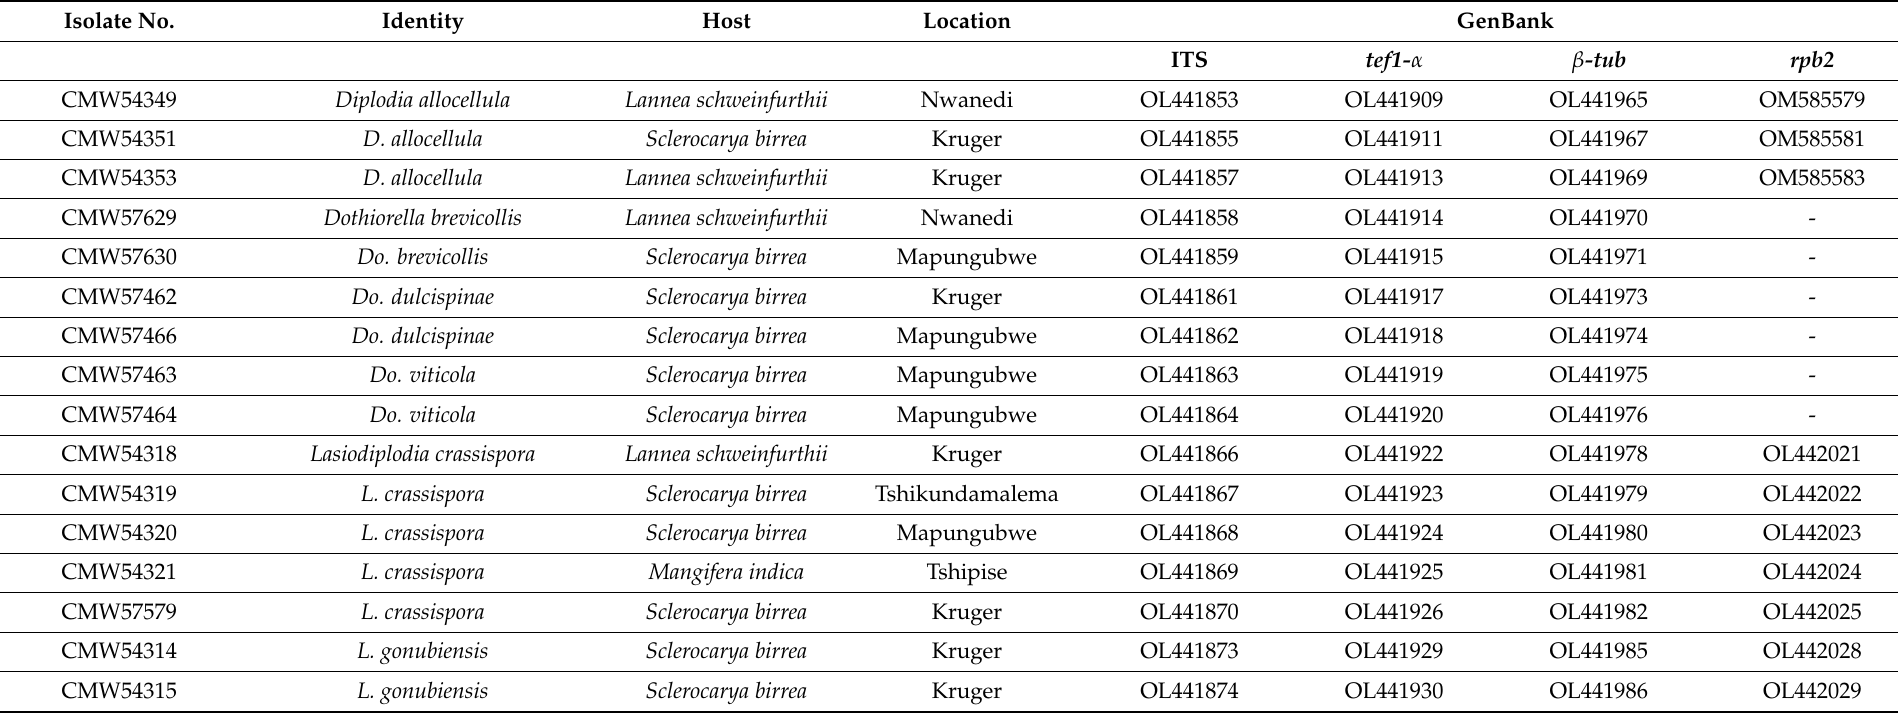
Table 1. Representative fungal isolates obtained from tree species of Anacardiaceae in this study and used in the phylogenetic analyses. Isolate